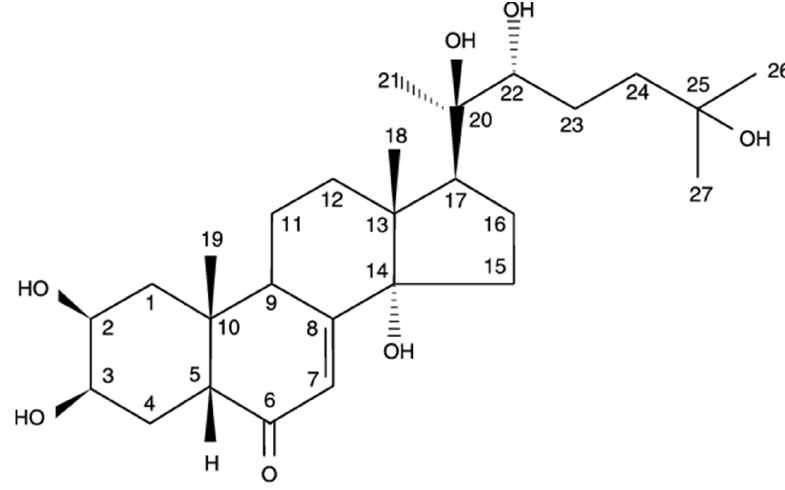
Figure 1. The structure of 20-HE.